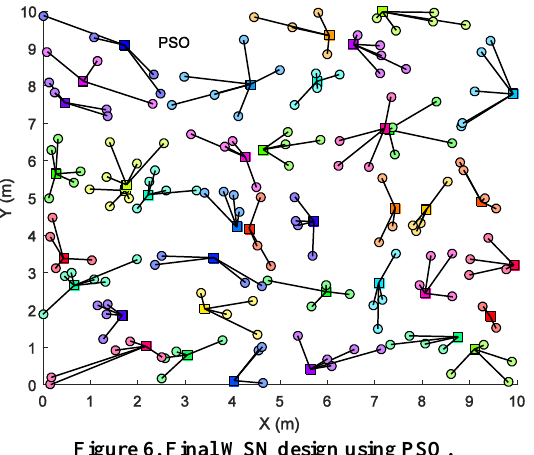
Figure 6. Final WSN design using PSO.